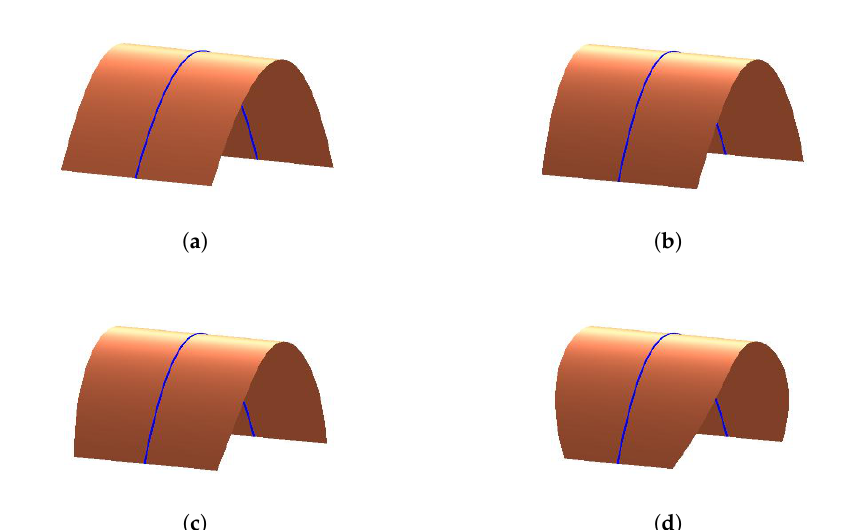
Figure 11. The effects of parameter α 2 on the developable surface through geodesic. ( a ) α 1 = π π , α 3 = π ; ( b ) α 1 = π 4 4